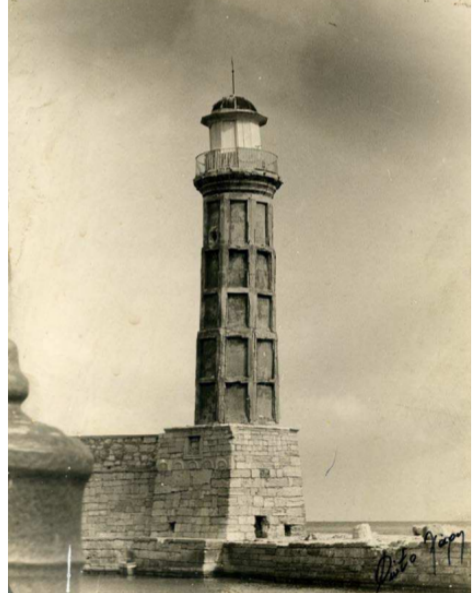
Figure 1. An older shot of the Egyptian lighthouse of